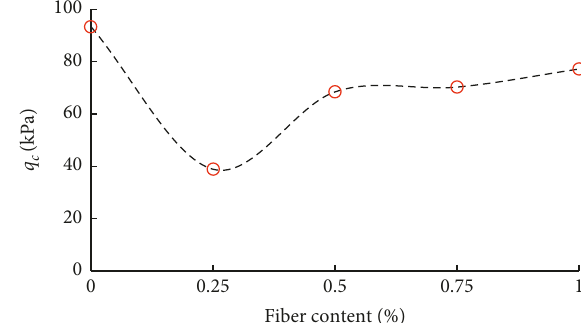
Figure 20: Residual strength q